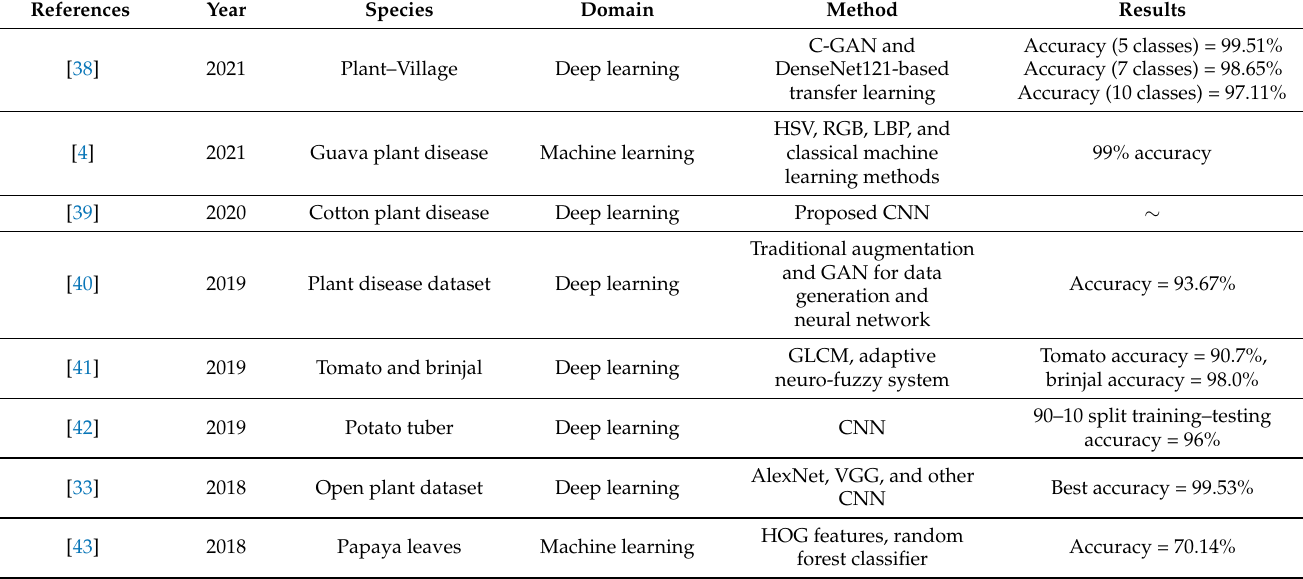
Table 1. Summary of recent studies on the detection of guava